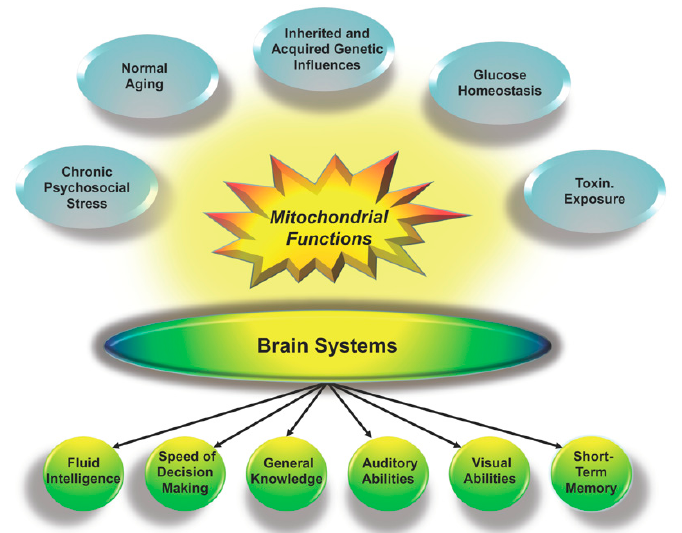
Figure 1. Mitochondrial health contributes to the functioning of brain systems at all levels from individual neurons to large-scale brain networks that support cognitive abilities. Mitochondrial health in turn is influenced by myriad factors, as illustrated by the surrounding ovals.